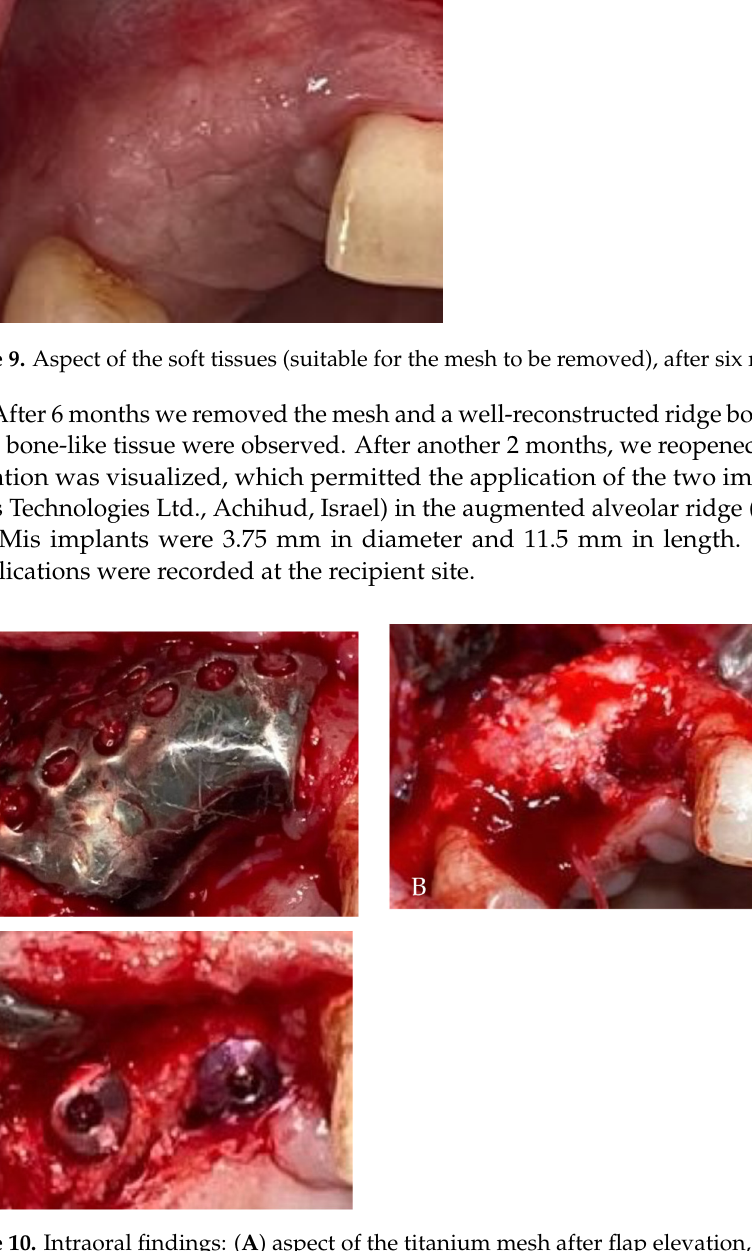
In order not to jeopardize the outcome, we minimized all risk factors to prevent mesh exposure (exposed mesh can lead to bone regenerating failure). Due to this consideration, in agreement with the patient’s decision, a provisional prosthesis was no longer produced. The healing was without inconvenience (Figure 9), with no membrane exposure, dur- ing the next 6 months.